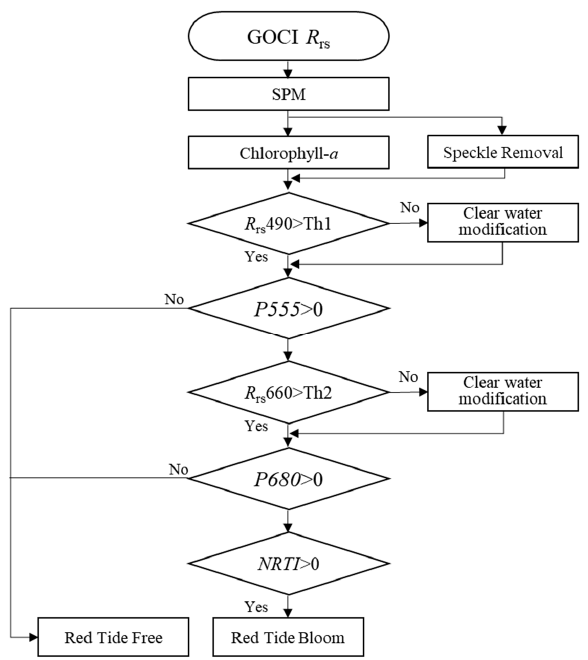
Figure 7. Flow chart of red tide detection procedures including preprocessing of data ( R rs ( λ ) , remote sensing reflectance) quality control, calculating each peak ( P555 and P680 ), and determining the existence of a red tide bloom (Th1 and Th2 are thresholds).